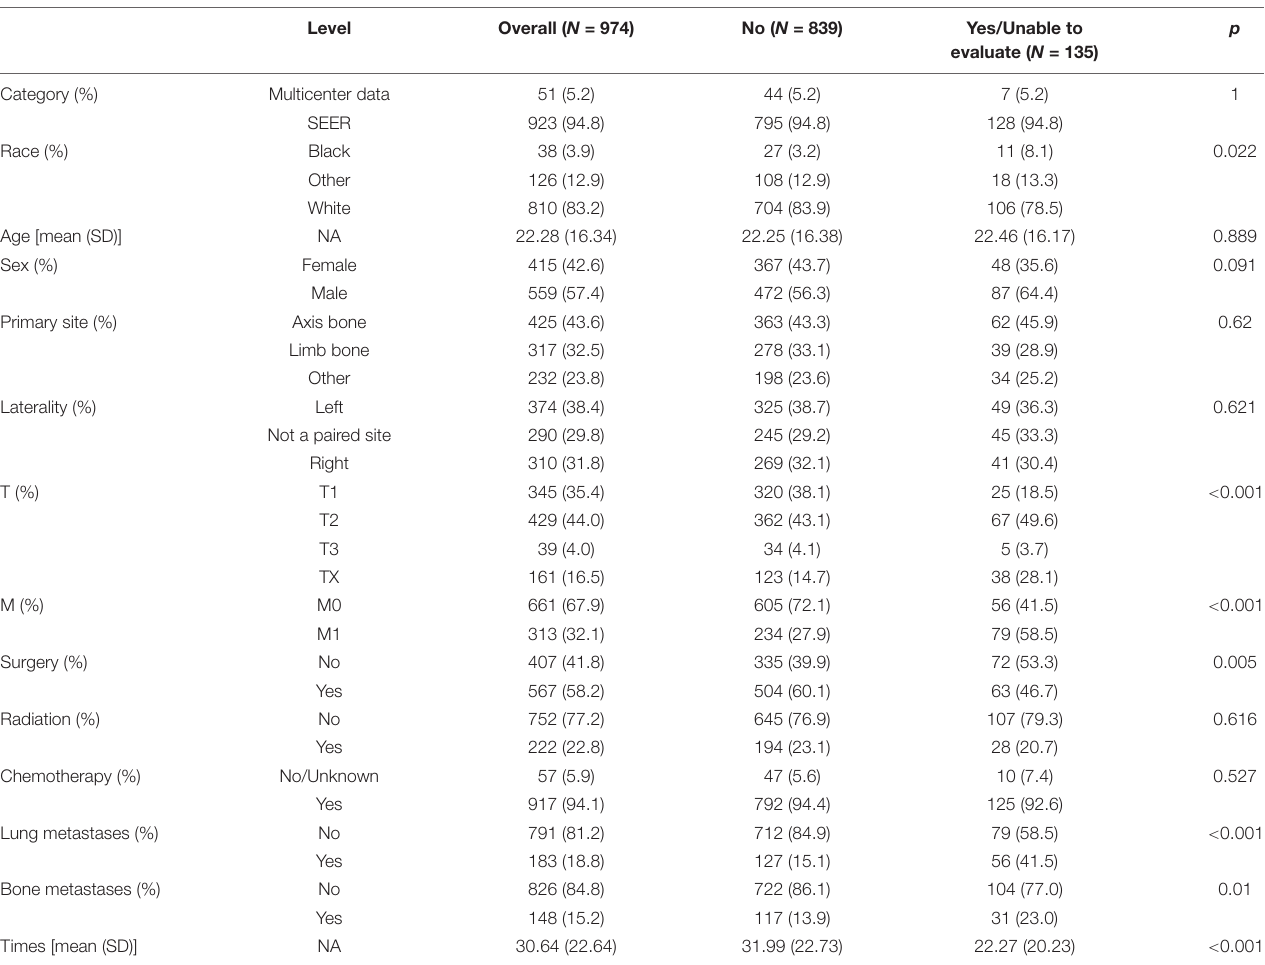
TABLE 2 | Patients baseline table of lymphatic